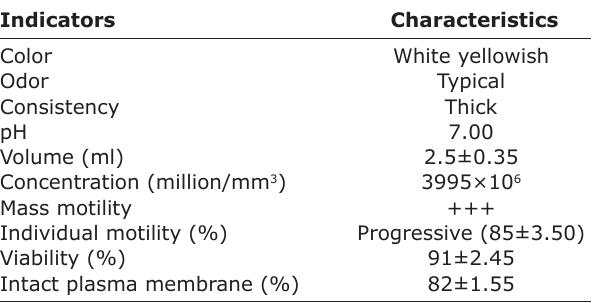
Table-1: Macroscopic and microscopic characteristics of fresh goat semen. Indicators